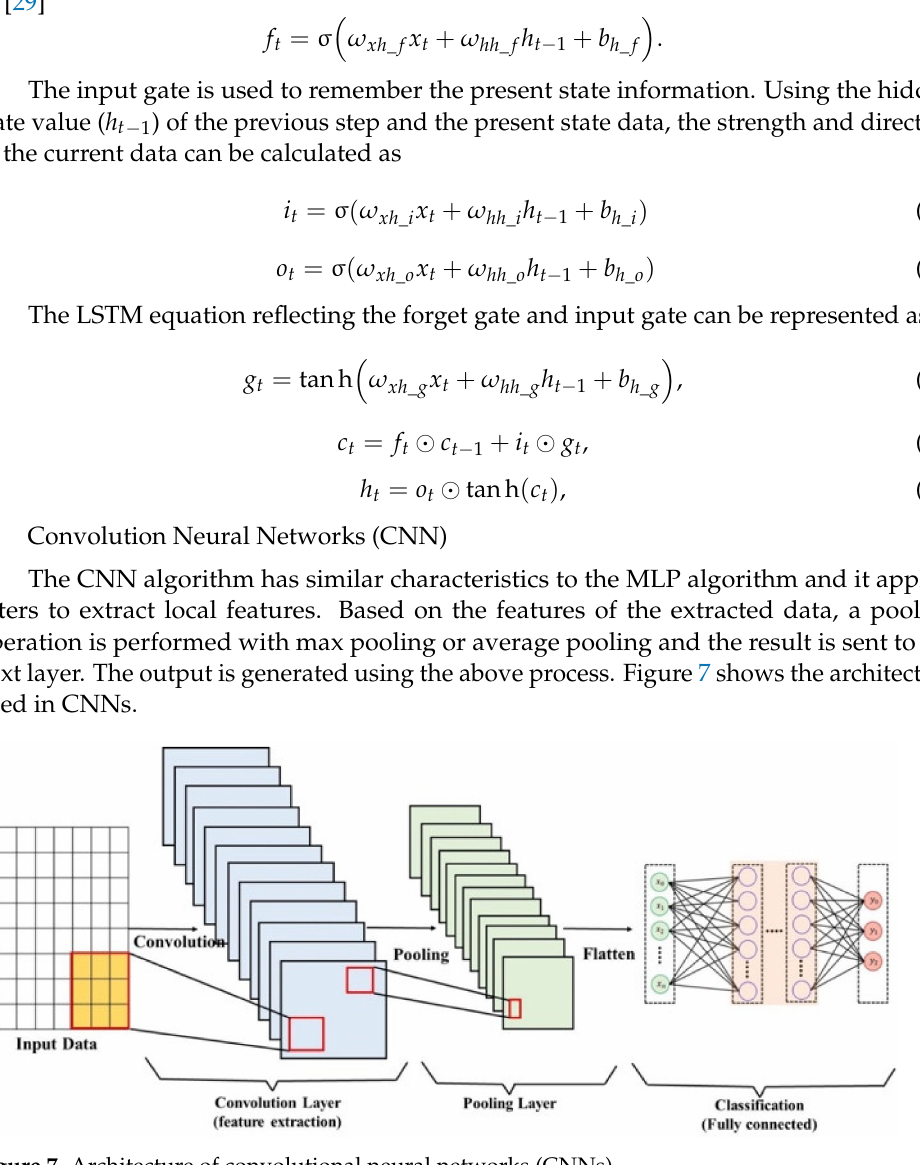
Figure 7. Architecture of convolutional neural networks